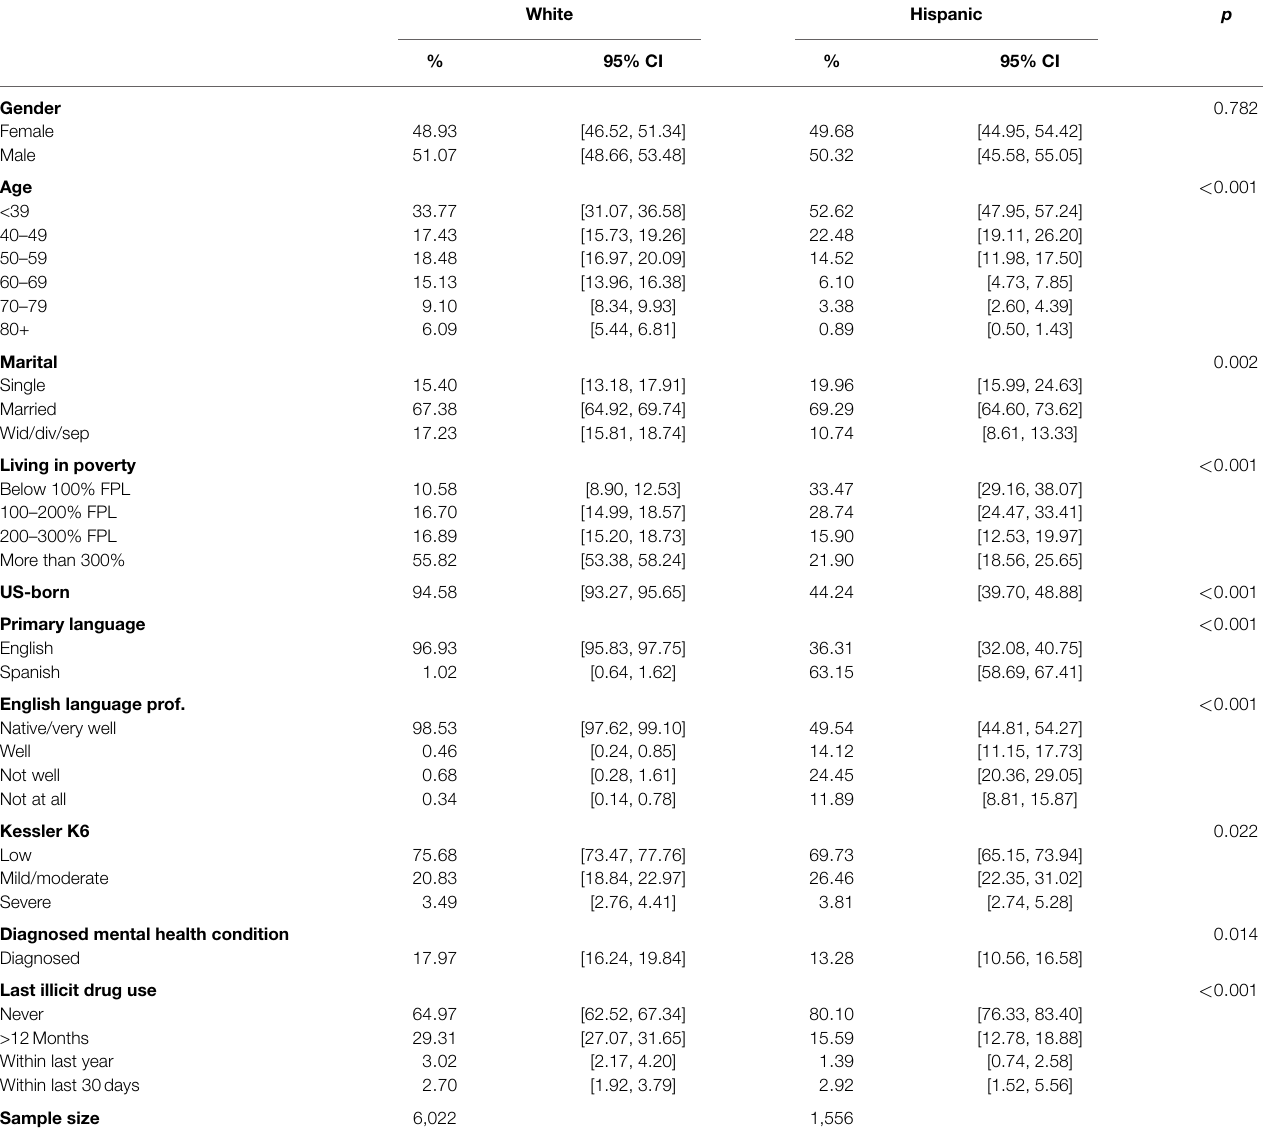
TABLE 1 | Demographic characteristics, mental health indicators, diagnosis rates, and illicit drug use of White and Hispanic respondents of the 2010 Arizona health survey ( n = 6,070) . White Hispanic p % 95% CI % 95% CI